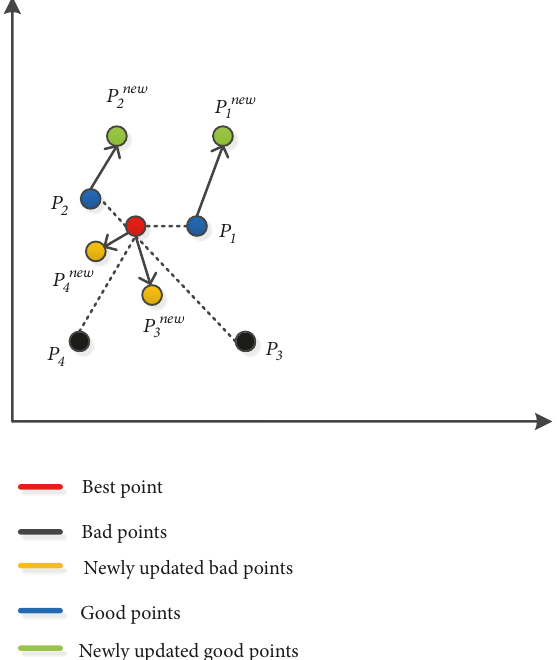
Figure 2: Strategy of searching new solutions of the proposed method.